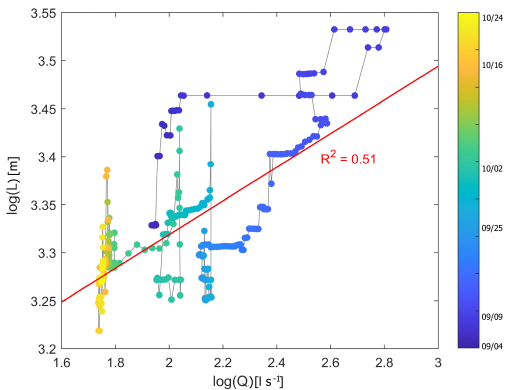
Figure 7. Plot of total discharge ( Q ) and total active length ( L